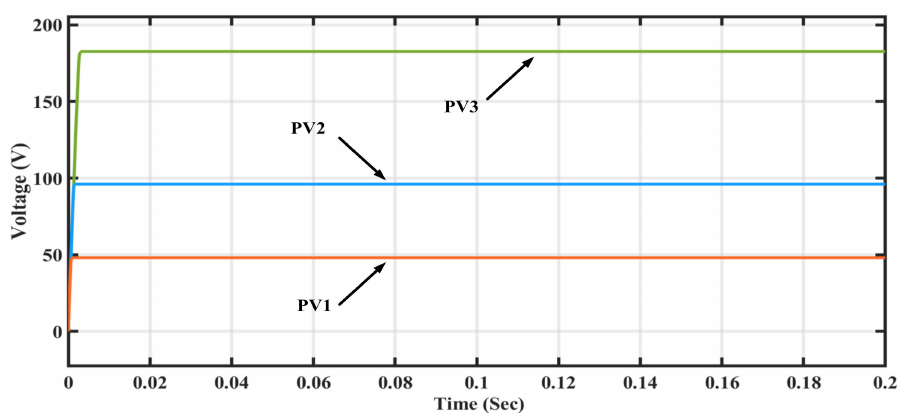
Figure 7. Asymmetric PV sources for the input of proposed 15-level inverter.